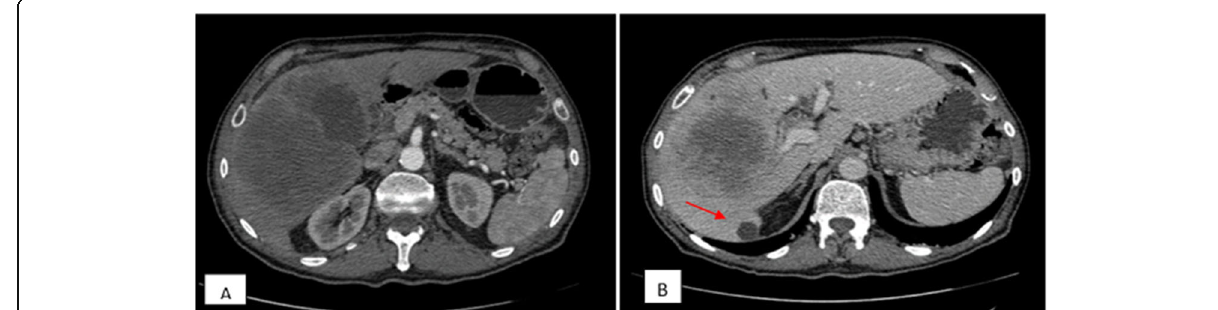
Fig. 1 a Abdominal CT scan, axial view, arterial phase, showing hypodense mass in the right lobe of the liver with weakly enhanced margin. b Portal phase, hypodense liver mass and the presence of hepatic cyst (red arrow). Mild dilation of intrahepatic biliary